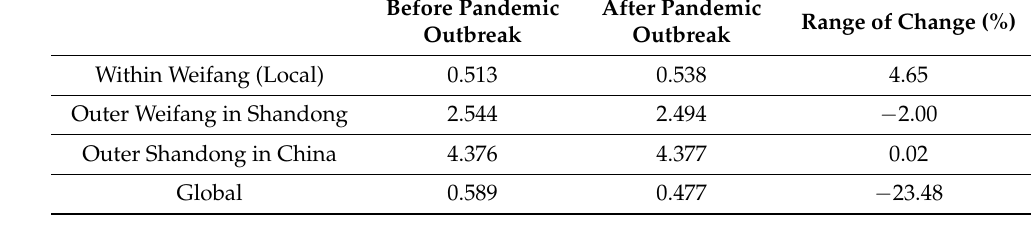
Table 5. Changes in node degree centrality of firms’ sales destinations at different geographical scales.